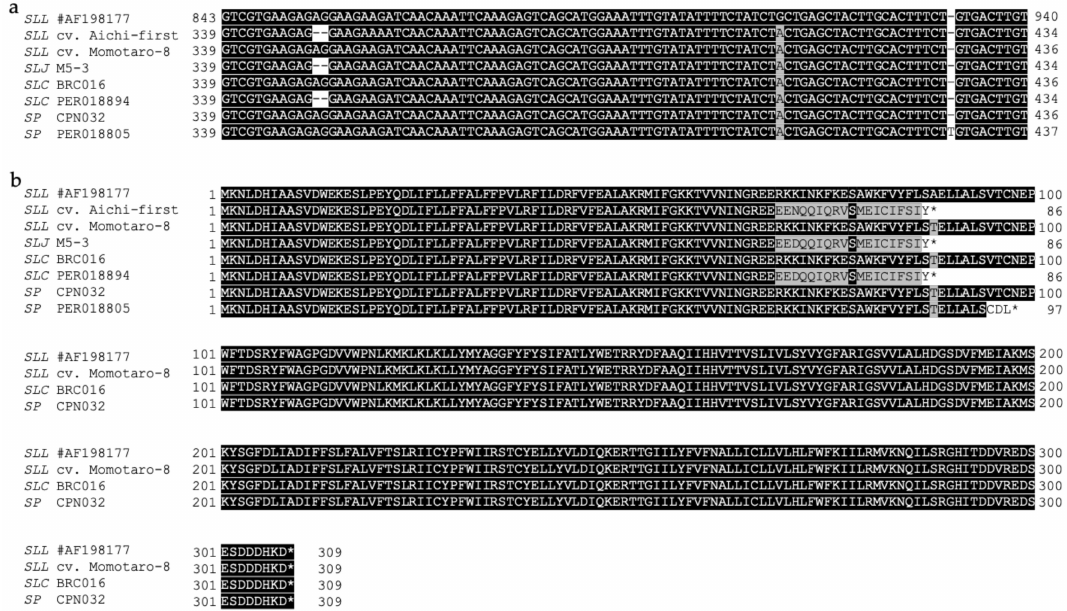
Figure 5. ( a ) Nucleotide variations found in exon 2 of Asc1 (Figure 3). Identical nucleotides are highlighted in black in comparison to the reference sequence of SLL #AF198177 (resistant to AAL-toxin). SLL cv. Aichi-first (susceptible), SLJ M5-3 (susceptible) from Mexico and SLC PER018894 (susceptible) from Peru have the nt 854_855del mutation, and SP PER018805 (susceptible) from Peru has the nt 931_932insT mutation. ( b ) Deduced amino acid sequences of Asc1 . The amino acid sequences were aligned using CLUSTALW [24]. Identical and similar amino acids are highlighted in black or gray, respectively, by GeneDoc [25]. * indicates termination. In comparison to the reference sequence of SLL #AF198177 (resistant to AAL-toxin), SLL cv. Aichi-first (susceptible), SLJ M5-3 (susceptible), SLC PER018894 (susceptible) and SP PER018805 (susceptible) produce smaller proteins that may be